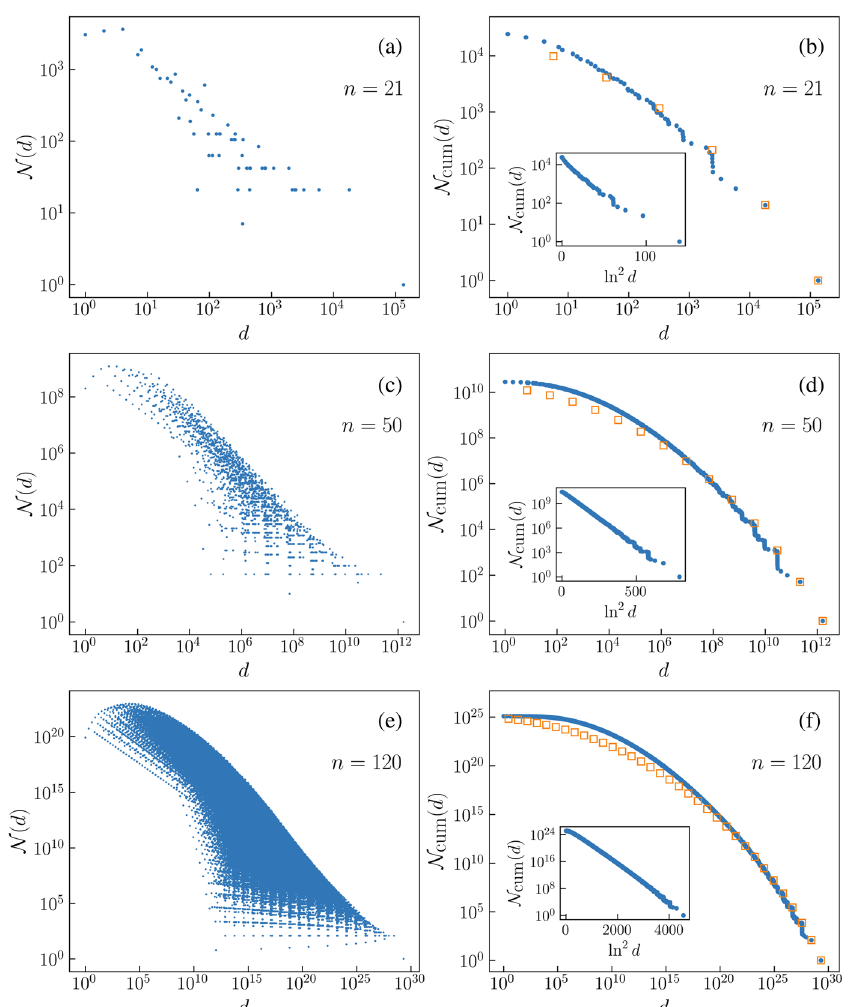
FIG. 3. (a),(c),(e) Degeneracy distribution for the complete input dataset: number of outputs of a given degeneracy versus degeneracy. (b),(d),(f) Cumulative degeneracy distribution for the complete input dataset: number of outputs of degeneracy greater than or equal to a given degeneracy versus degeneracy. The input length is n ¼ 21 , 50, 120. Open square symbols represent a mean-field approximation to the cumulative distribution, given by Eq.